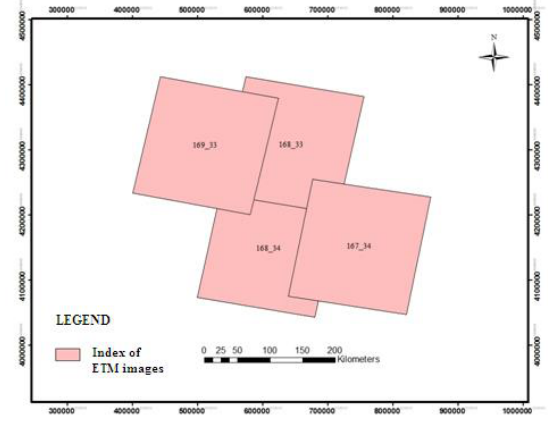
Figure 2: Index of ETM images (Author)